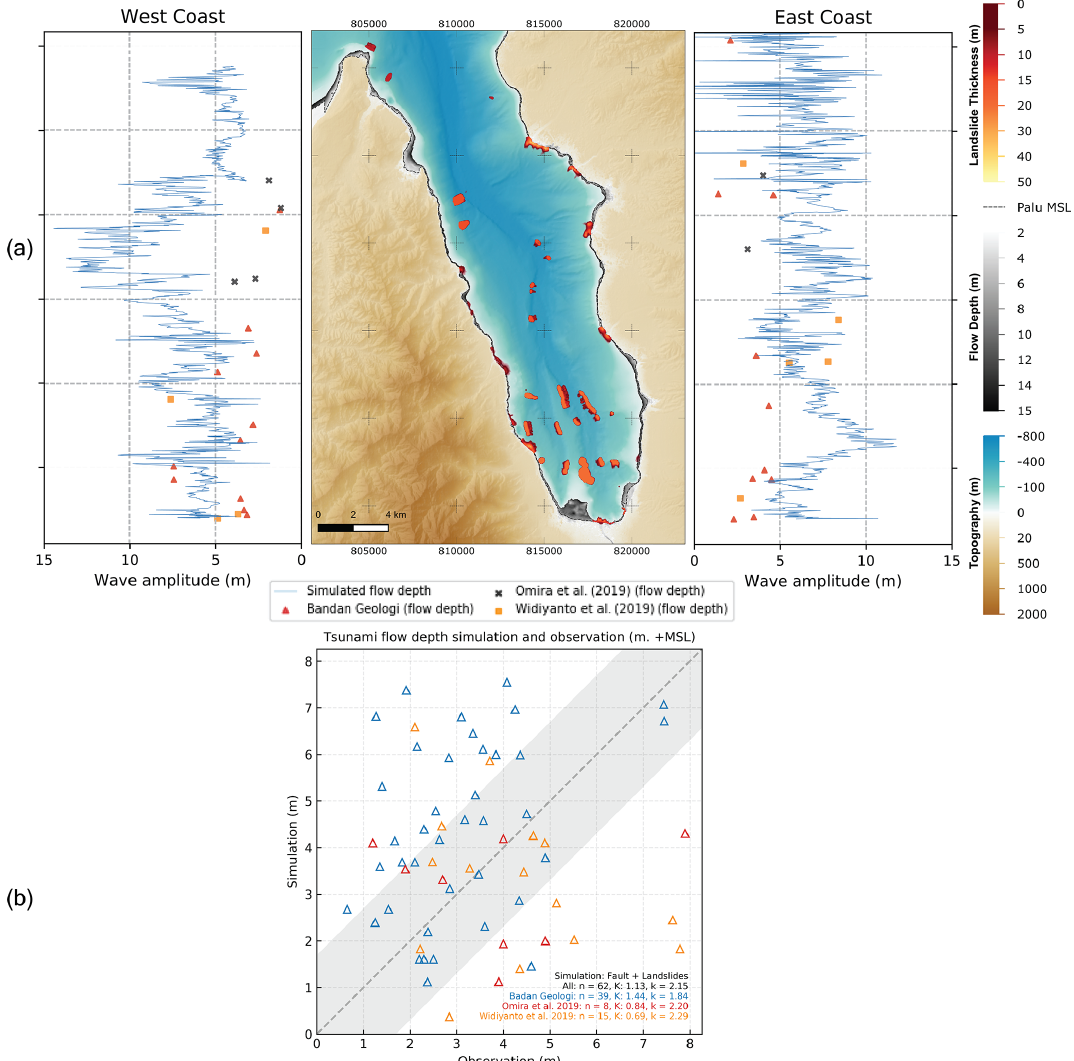
Figure 8. Simulated tsunami inundation depth (flow depth) with the modeled submarine landslides and observed submarine landslides from previous studies. All the submarine landslides presented in the figure were used to model the tsunami flow depth. (a) Calculated maximum flow depth (center) with the maximum calculated flow depth (blue line) at the shoreline of the western coast (left) and the eastern coast (right) and the measured inundated depths from Badan Geologi’s report (red triangles), Omira et al. (2019) (crosses), and Widiyanto et al. (2019) (yellow squares). (b) Comparison between simulated and observed tsunami inundation depths by the Badan Geologi (2018) report (blue), Omira et al. (2019) (red), and Widiyanto et al. (2019) (yellow), as well as the comparison index, K , and κ values. n stands for the total number of observations. The gray shading represents the error related to the over-/underestimation, i.e., ± standard deviation ( ∼